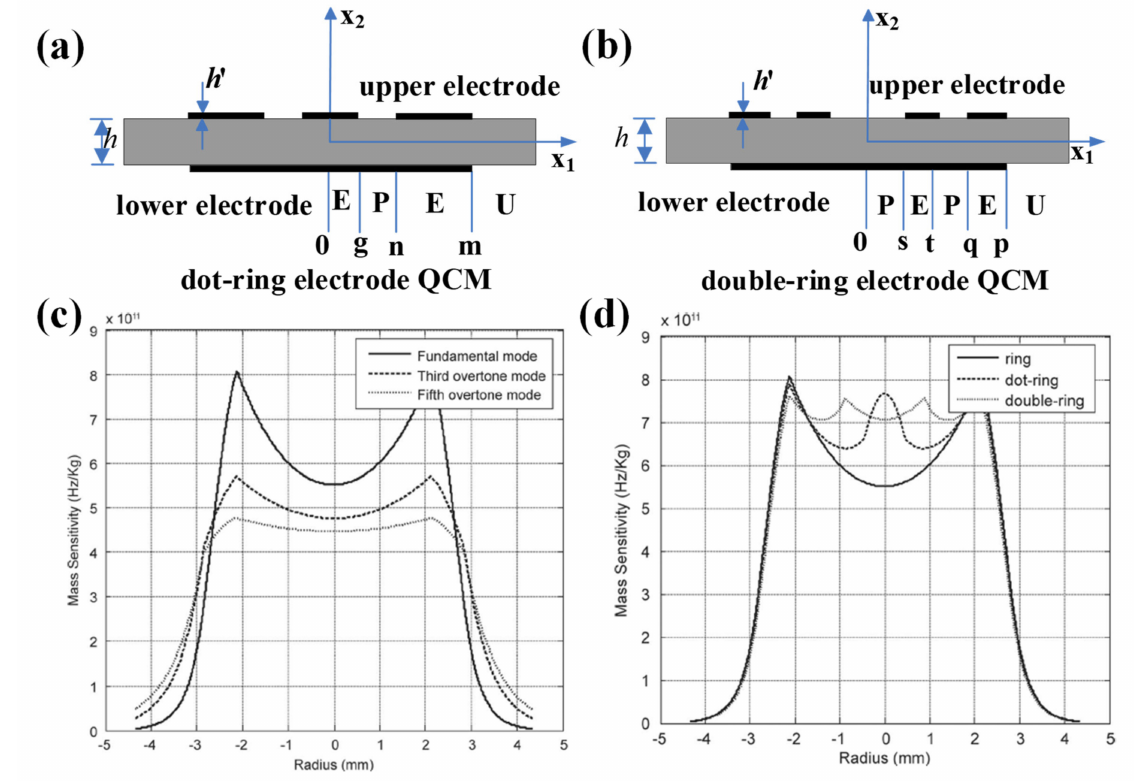
Figure 4. Schematic diagram of the structure of the ( a ) dot-ring electrode QCM and ( b ) double-ring electrode QCM. Mass sensitivity distribution for ( c ) ring electrode QCMs with fundamental, third overtone, and fifth overtone operating frequencies of 10 MHz. ( d ) Ring, dot-ring, and double-ring electrode quartz crystal resonators with fundamental operating frequencies of 10 MHz [50]. Here, g, n, and m denote the radius of the center dot and the inner and outer radii of the outer ring for the dot-ring electrode QCM, respectively. s, t, q, and p denote the inner and outer radii of the inner ring and the inner and outer radii of the outer ring for the double ring electrode QCM,